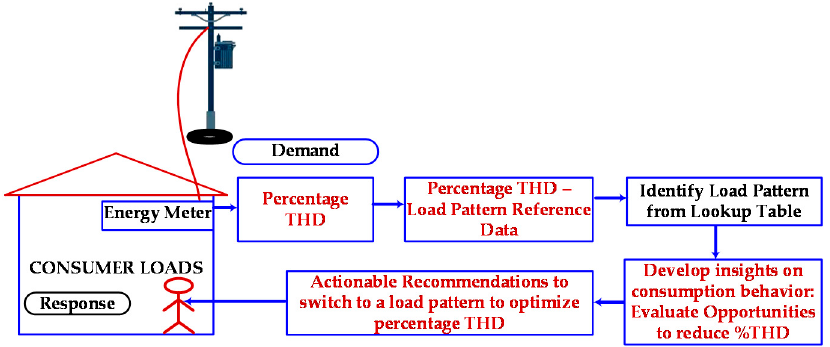
Figure 2. DR management in view of load monitoring using % Total Harmonic Distortion (THD).